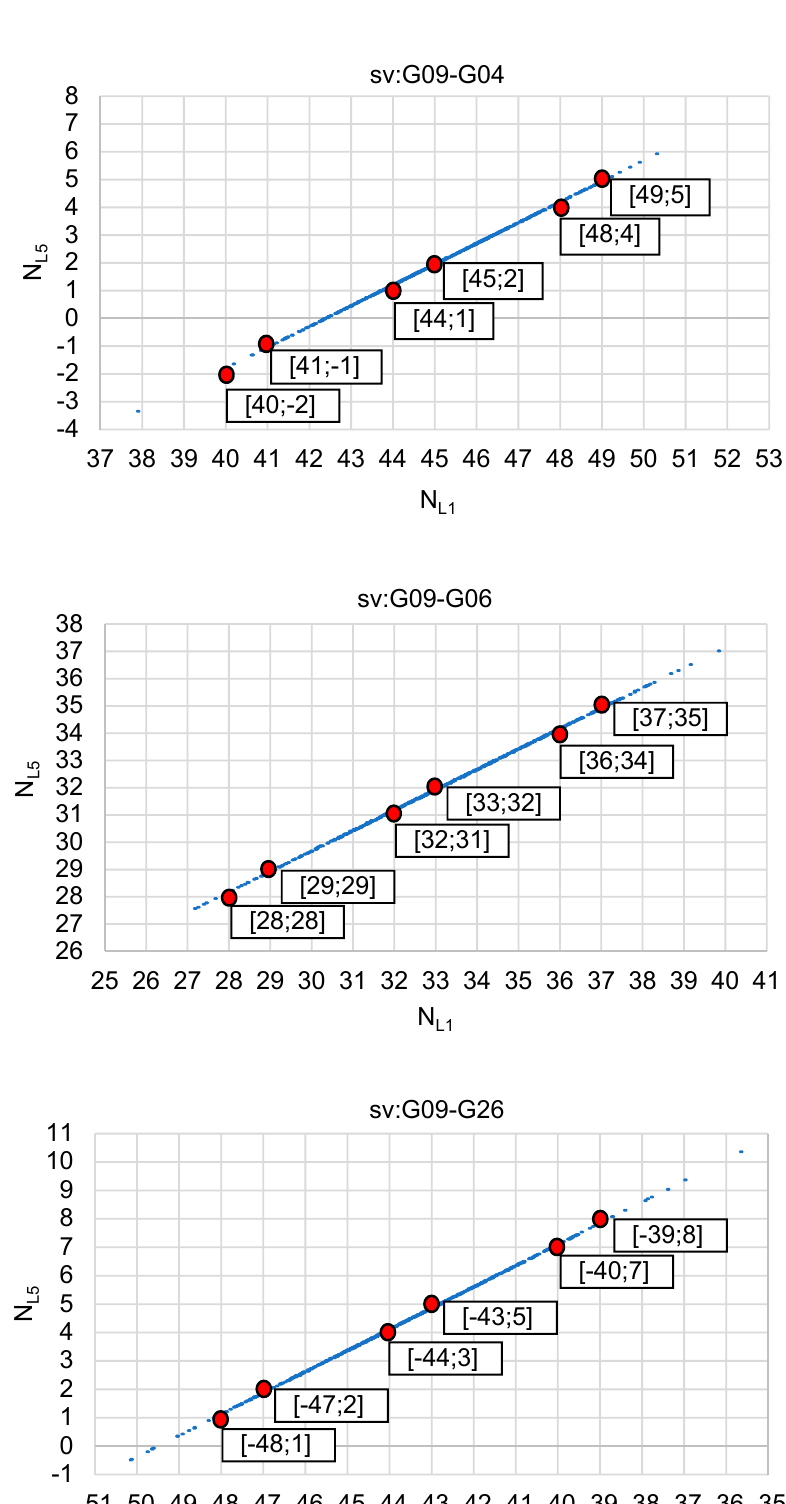
Figure 10. Integer candidates of ambiguity initialization for satellites: G09–G04, G09–G06, G09–G26 if relative errors of carrier phases L1–L5 are below 7 cm, with the use of the PREFMAR approach.